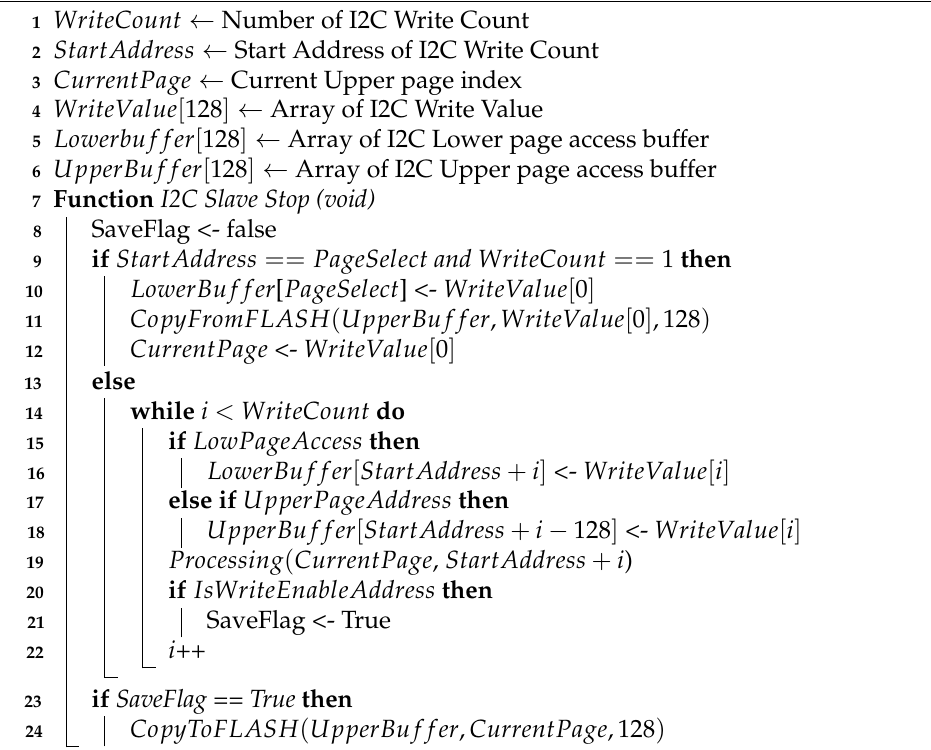
Algorithm 1: QSFP28 register